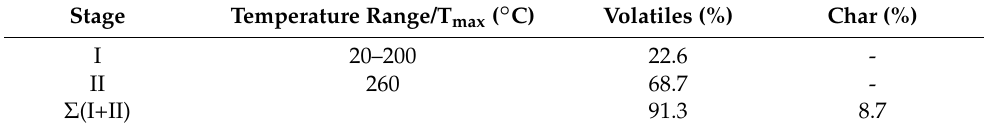
Figure 3. ( a ) Differential thermal analysis (DTA), differential thermogravimetric analysis (DTG), thermogravimetric (TG) curves; ( b ) Vapor pressure measured as a function of temperature (P-T); ( c ) temperature-programmed desorption (TPD) curves for ions with m / z 44, 28, 18, 3; ( d ) deconvolution of TPD curve for ions with m / z 44 for CA/CeO 2 (0.6 mmol/g). Table 2. Pyrolysis yields for thermogravimetric analysis (TGA) pyrolysis of CA/CeO 2 (0.6 mmol/g).